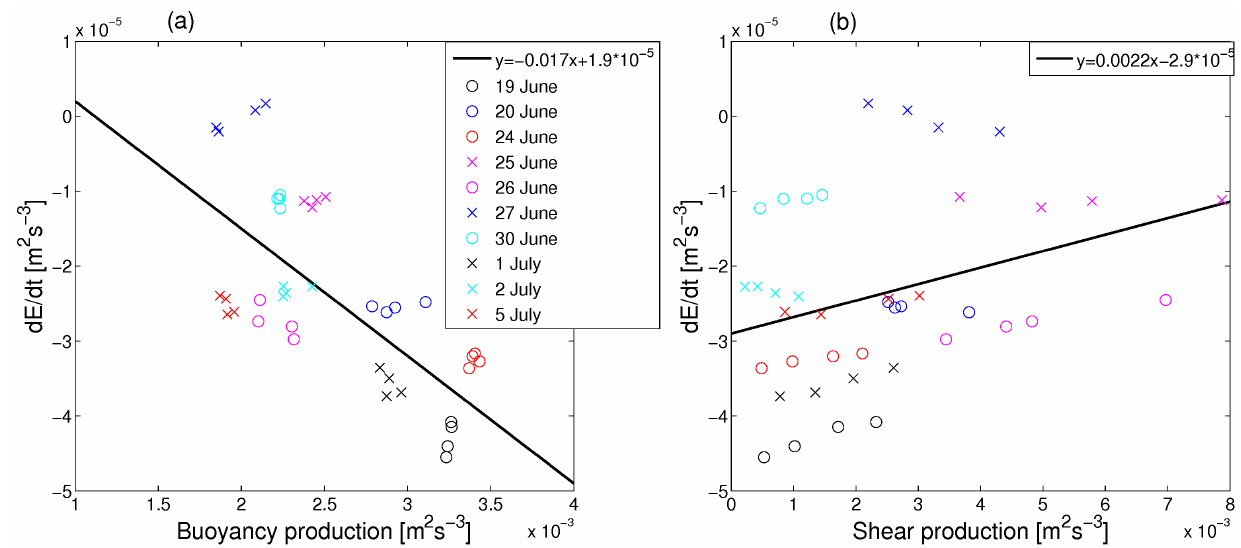
Figure 7. Average TKE tendency for each afternoon is shown as a function of buoyancy production in panel (a) and shear production in panel (b) . Table 1. TKE budget classification of the 10 IOP afternoons. Here, wind speed, shear production, transport and dissipation have been classified into three categories (“h”: higher; “m”: moderate; “w”: weaker) and the buoyancy production into two categories (“h” and “m”) based on the mean values for the afternoon (see text for exact limits). Furthermore, in parentheses “p” denotes whether only part of the afternoon is considered to belong to the category. For the moderate category an extra “l” or “h” indicates whether the variable is mainly departing towards the lower or higher category. For dissipation, two days are denoted with “(inc)” to indicate that dissipation increased during the afternoon. To interpret some of the main effects of higher or weaker wind speed on the TKE budget, combinations of underlining, italics and bold font have been added to the table (see text for further explanation).